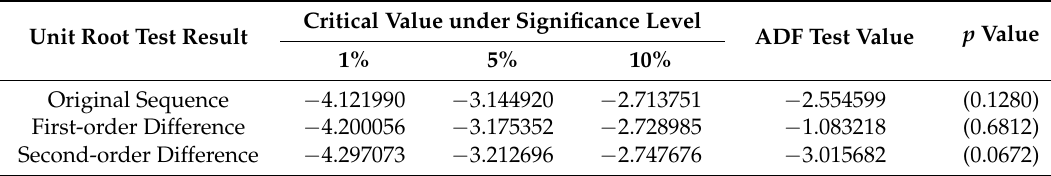
Table 1. ADF (Augmented Dickey-Fuller test) test on per capita GDP index of China